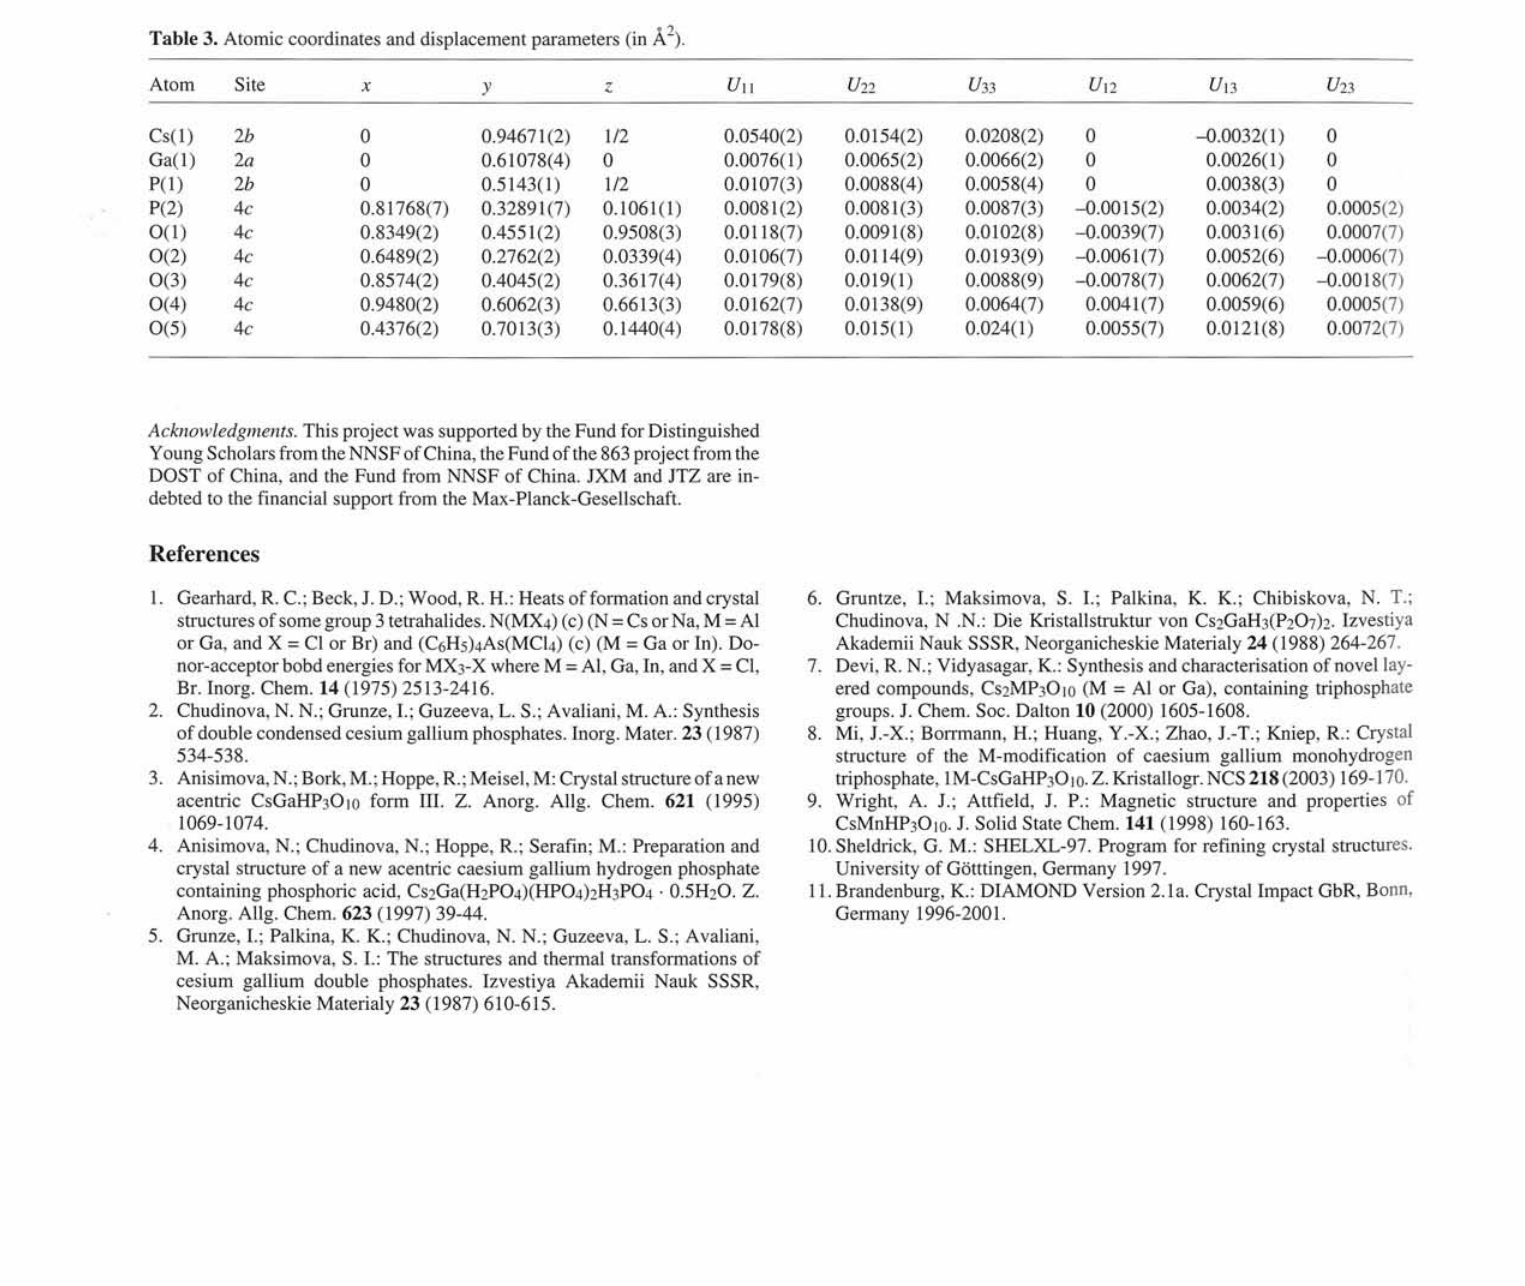
Table 3. Atomic coordinates and displacement parameters (in Á 2